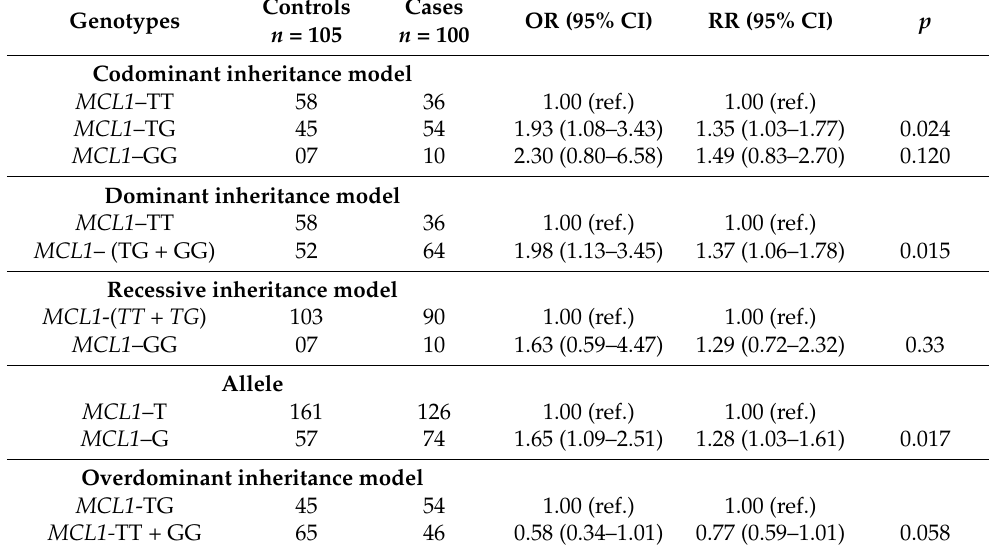
Table 5. Association of MCL1 - rs9803935 T > G gene variation in cases and